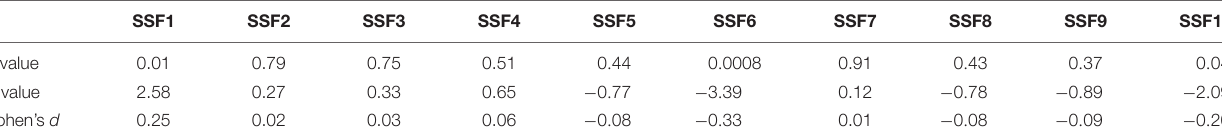
FIGURE 2 | The percentage of the variance accounting for (%VAF) for each pattern. TABLE 2 | The two-sample t -test results of SSFs of the first 10 patterns between ADHD and TDC